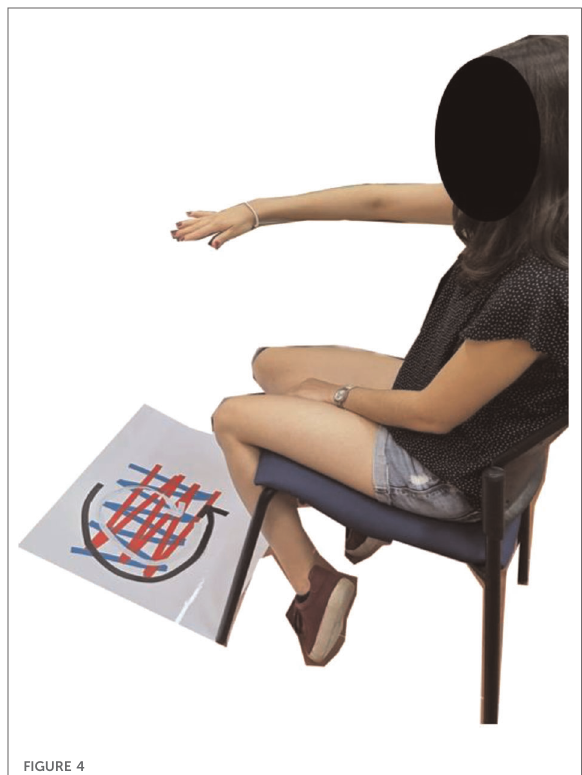
FIGURE 4 Color-coded tracks, blue: forward and backward, red: right and left, white: clockwise, black,